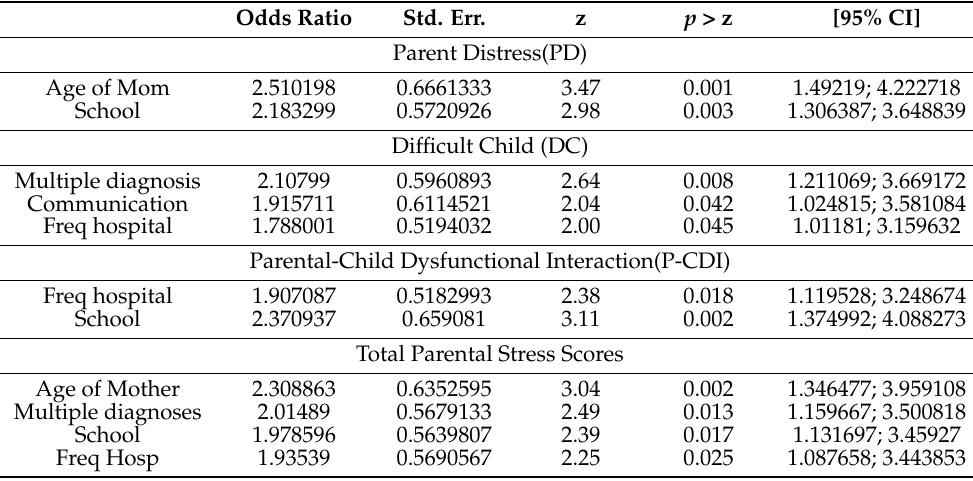
Table 5. Multivariate logistic regression: Subscale level and total parental stress. Odds Ratio Std.